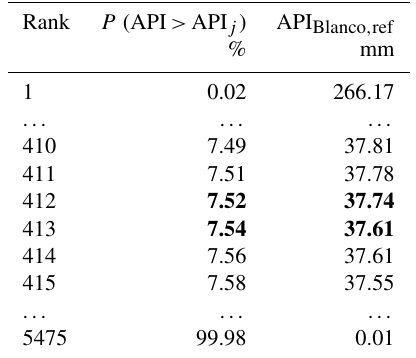
Table A2. The (bold) API value found in Table A1 is compared to the sample of API values estimated for the donor years (i.e., 1948– 1963) at the donor basin (i.e. Blanco River, TX). The closest val- ues are considered and the corresponding percentiles estimated (in bold).